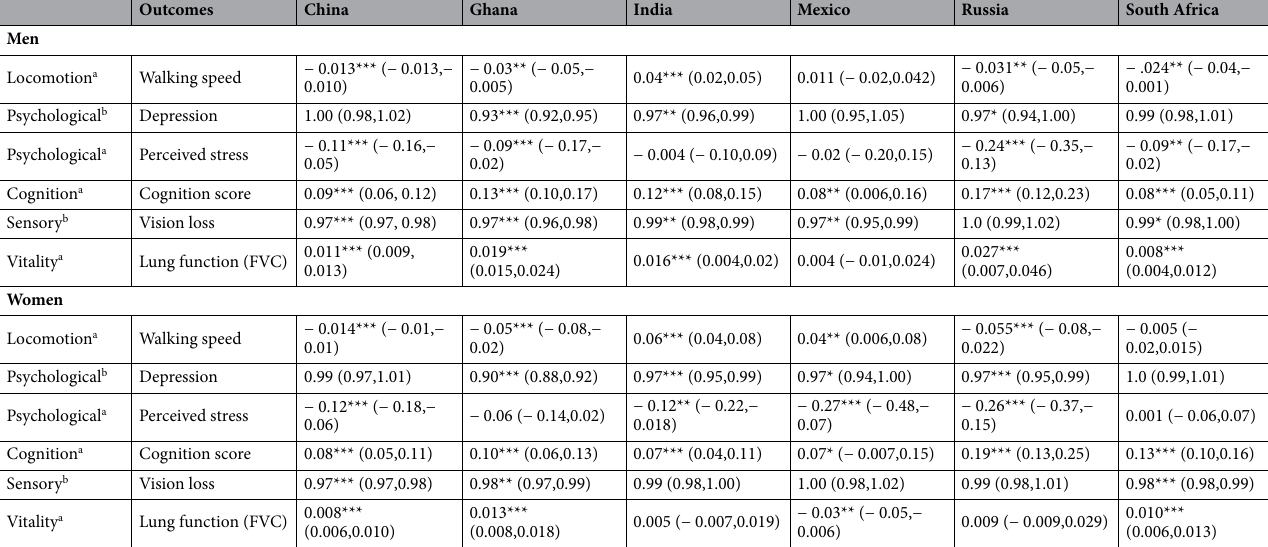
Table 3. Association of handgrip strength (kg) with selected measures of intrinsic capacity among men and women aged 50 + in six middle-income countries, WHO-SAGE Wave 1 (2007/10). FVC forced vital capacity. All regression analyses were adjusted for age, place of residence, years of schooling, wealth quintile, work status, body mass index, self-rated health and multimorbidity. a Results are presented in coefficient with 95% confidence interval. b Results are presented in odds ratio with 95% confidence interval. ***p < 0.001, **p < 0.005, *p <